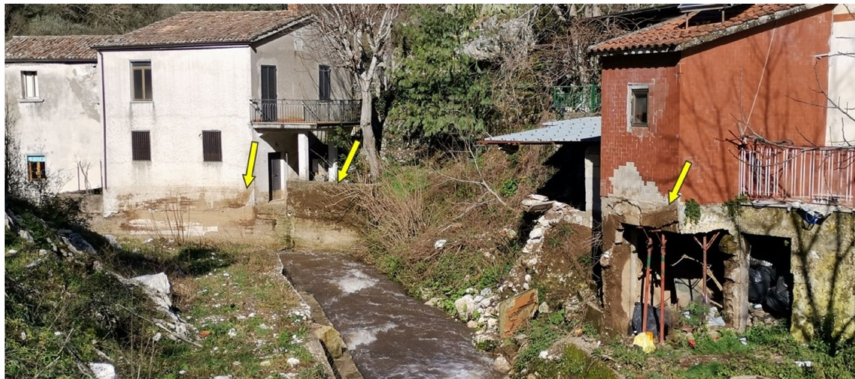
Figure 12. View of Caudino Torrent downstream of the first covered segment (cf. Figure 6) and houses hit by the 2019 debris flow. The indicators of the flow thickness are shown by the arrows.